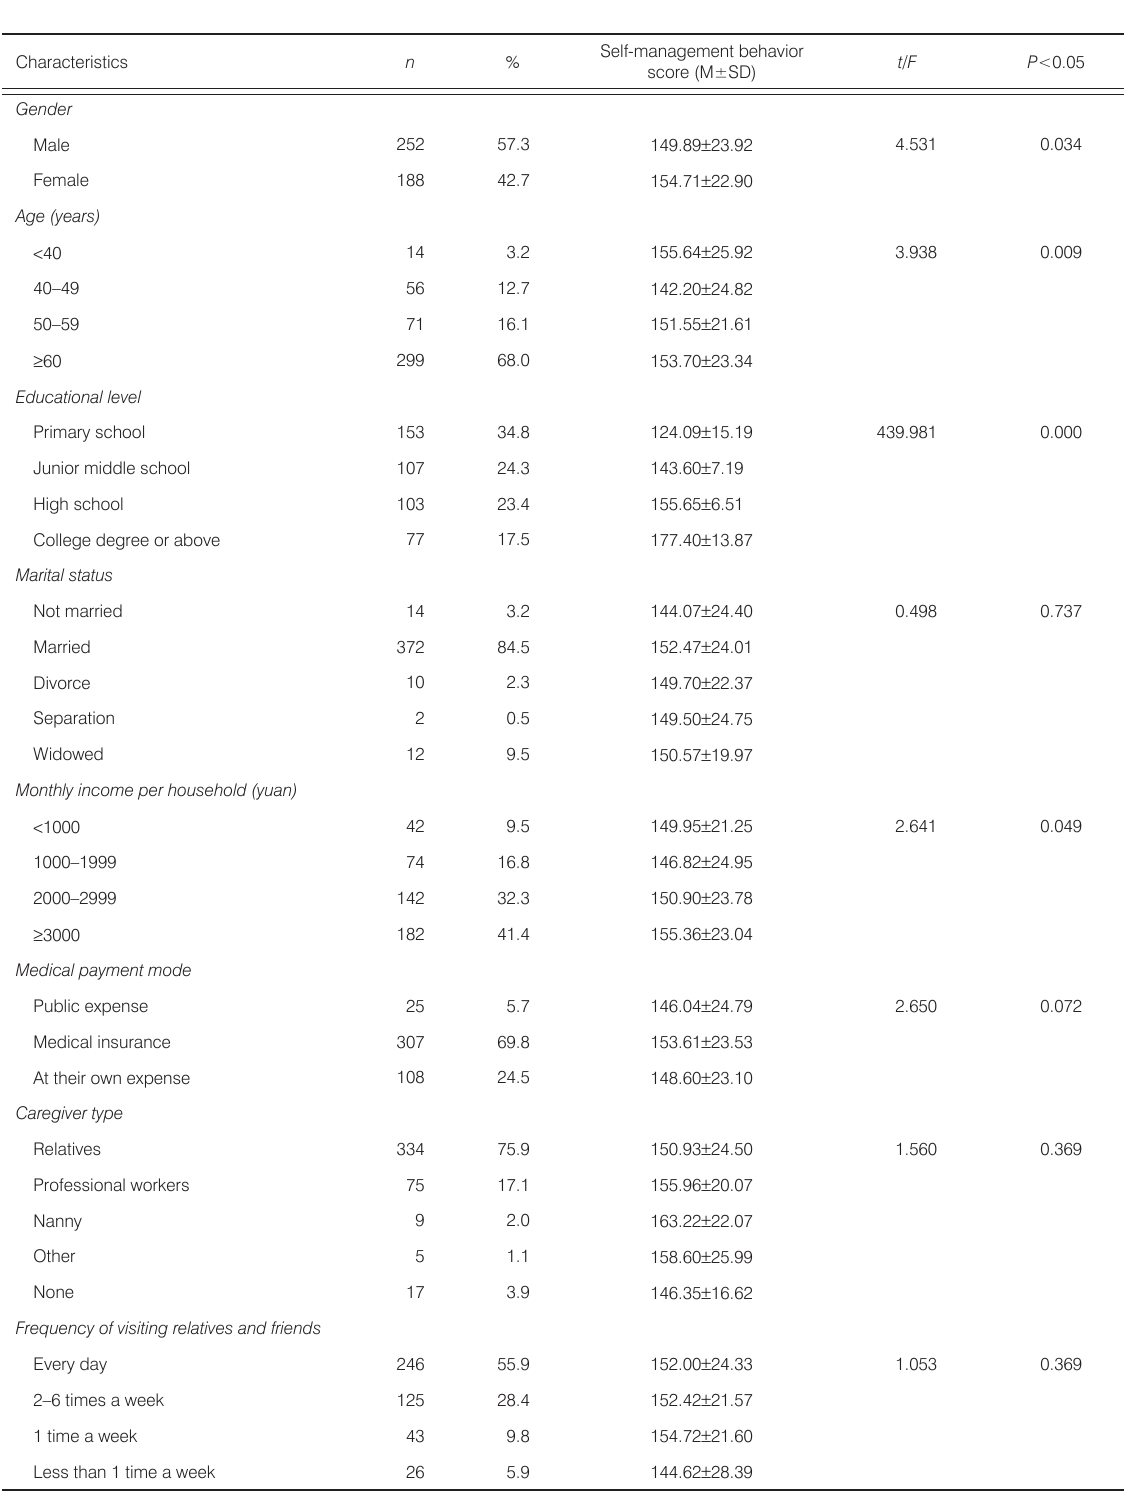
Table 3. Single-factor analysis of demographic data of patients in the stroke recovery stage ( n